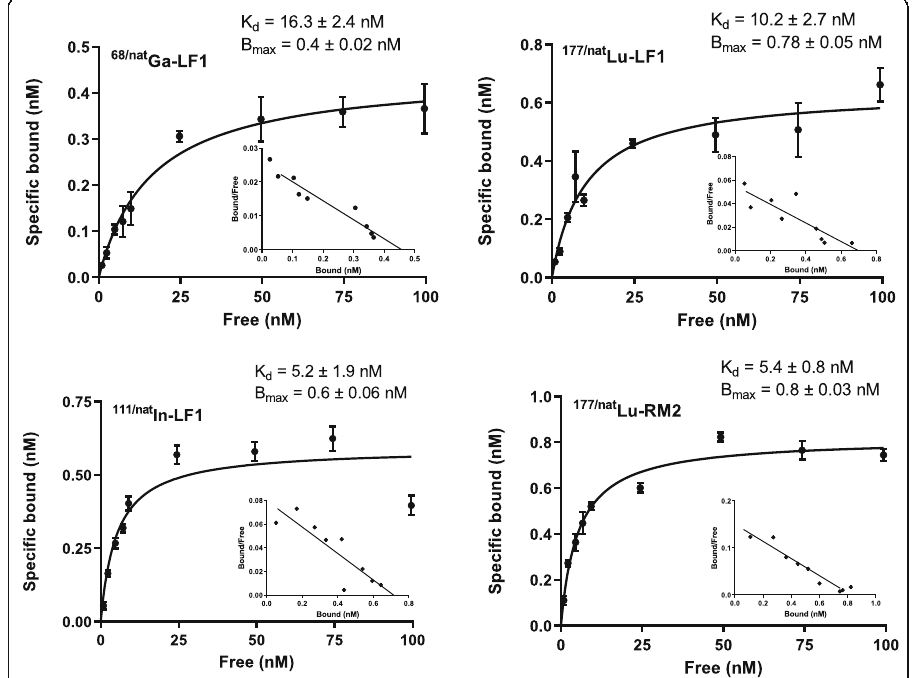
Fig. 3 Saturation binding study on intact PC3 cells, using increasing concentrations of 68/nat Ga-LF1, 177/nat